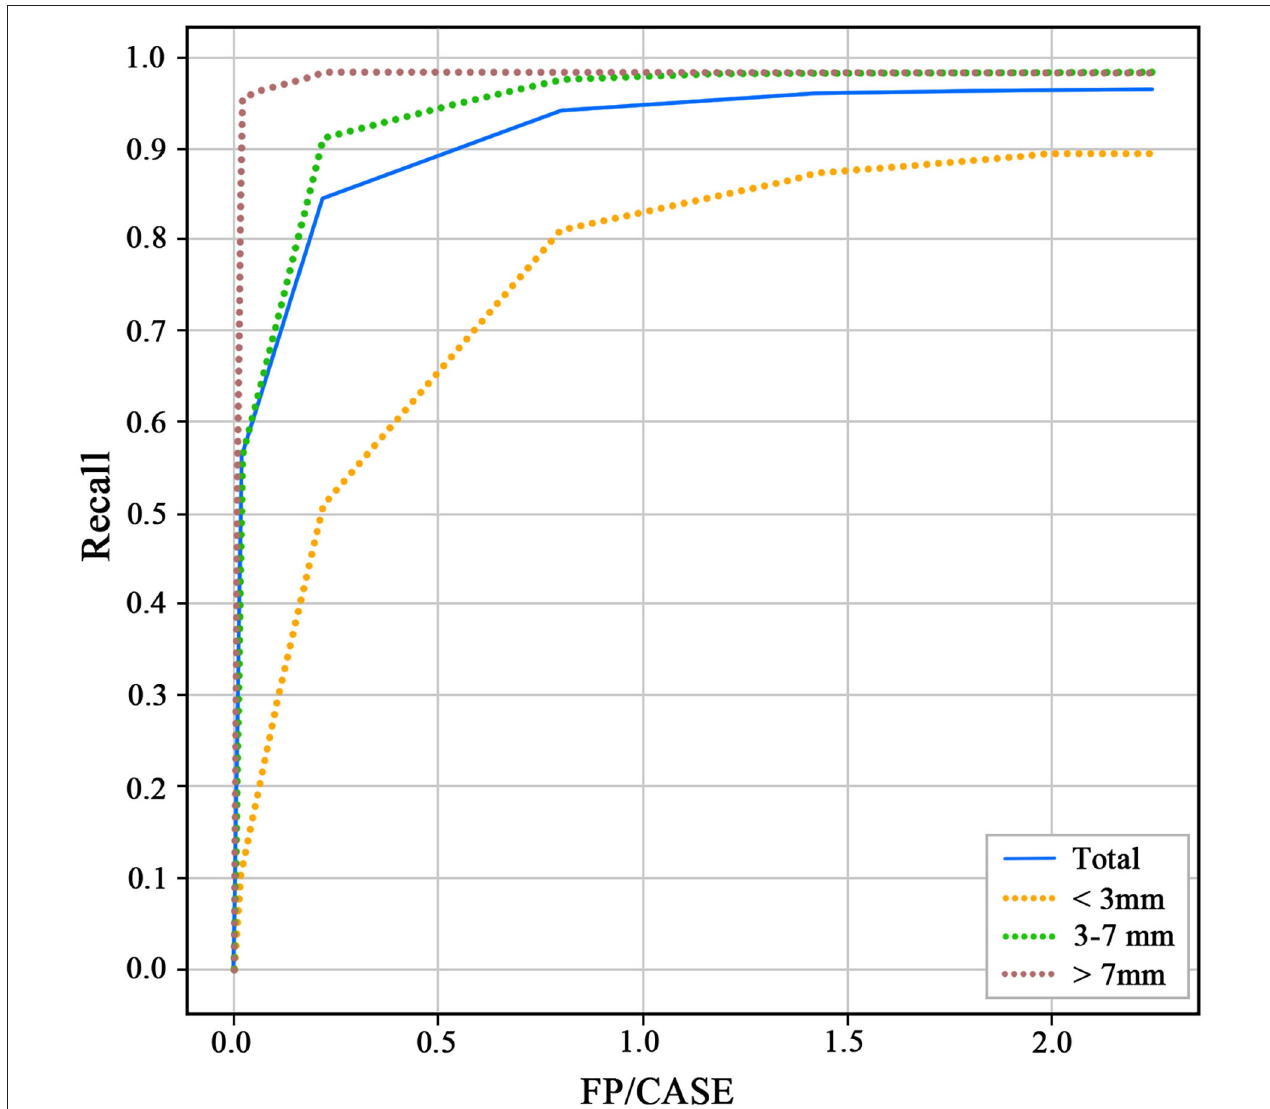
FIGURE 3 | Receiver operating characteristics (ROC) of different size aneurysms for the test dataset.